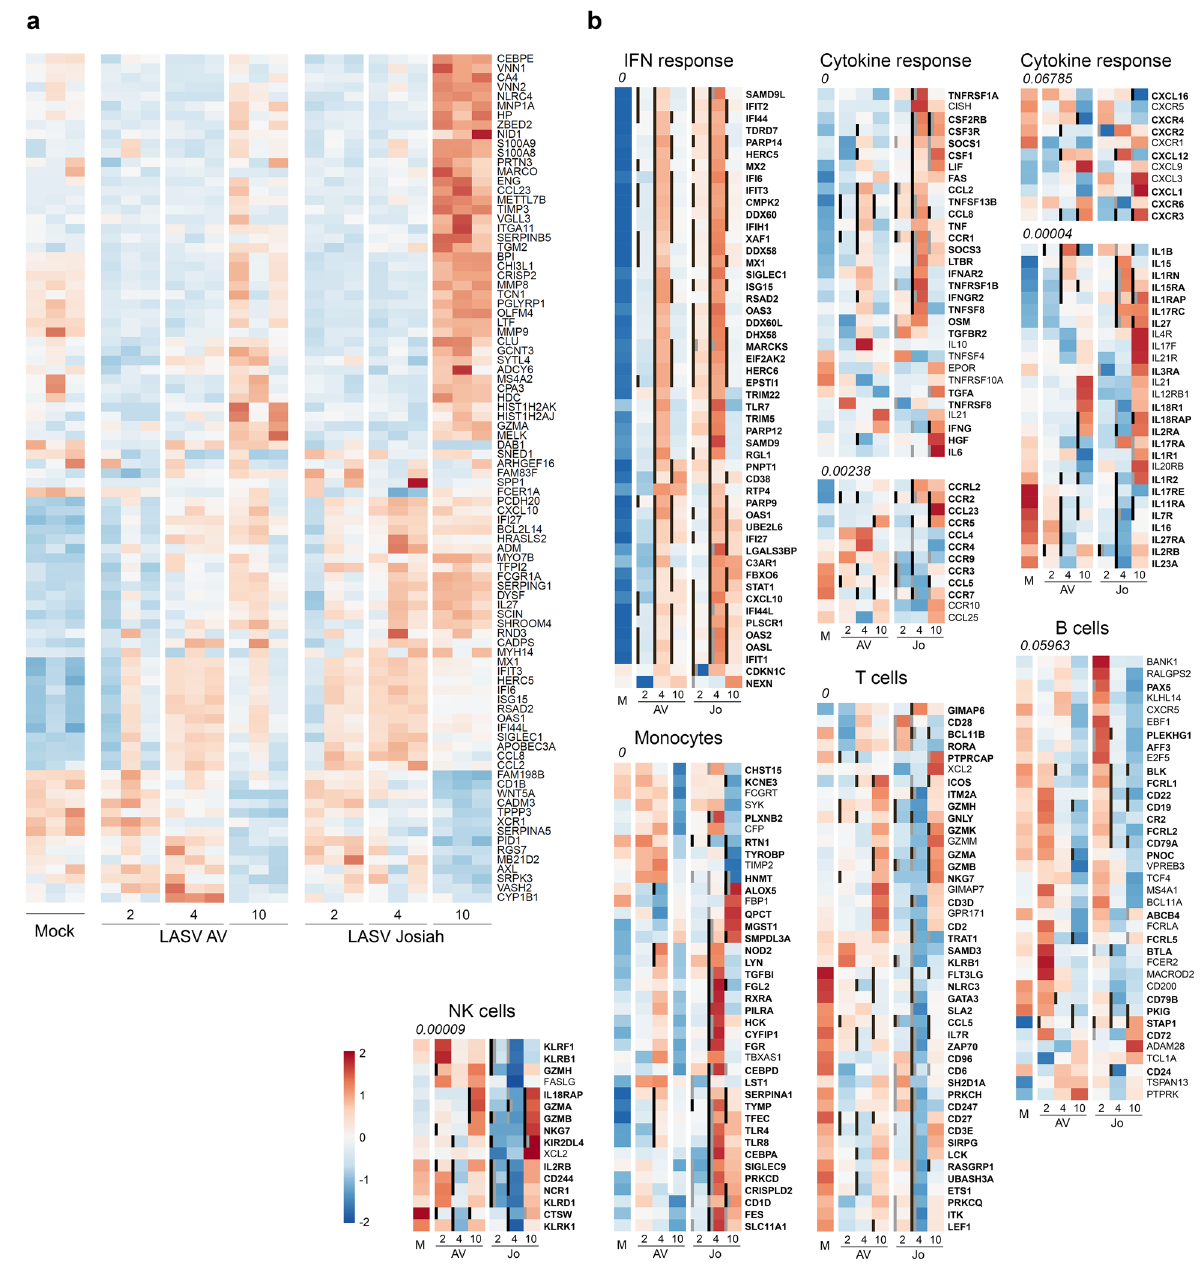
Fig. 8 Analysis of transcriptomic data of PBMCs. a Heatmap of the 100 most differentially expressed (DE) genes (absolute Log2 fold-change larger than 5). Gene expression was standardized using VST transformation, hence centered and scaled to make the gene expression comparable. Each column corresponds to the mean gene expression of the three animals of each group for a given timepoint. b Heatmap of gene expression of six gene sets. Signi fi cant genes are highlighted with bold labels and corresponding signi fi cant comparisons are displayed by gray (signi fi cant difference between Josiah and AV for a given day) and black vertical bars (signi fi cant difference with the mock condition). Gene expression was standardized using VST transformation, centered and scaled to make the gene expression comparable, hence averaged by condition and timepoint. An enrichment test was performed, using a one-tailed Fisher test. P values were adjusted on multiple comparisons using Benjamini – Hochberg correction and were presented under the gene set